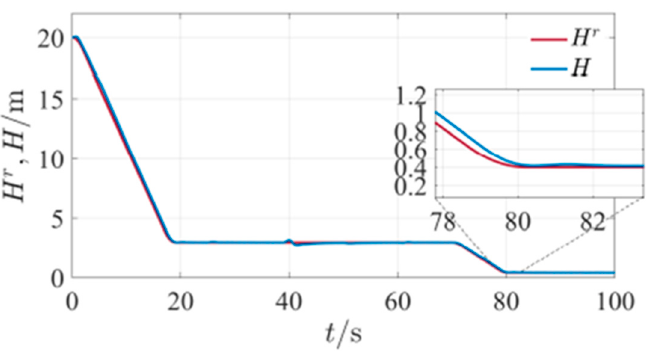
Figure 36. The evolution of the altitude of the mobile platform vs. time during landing process.